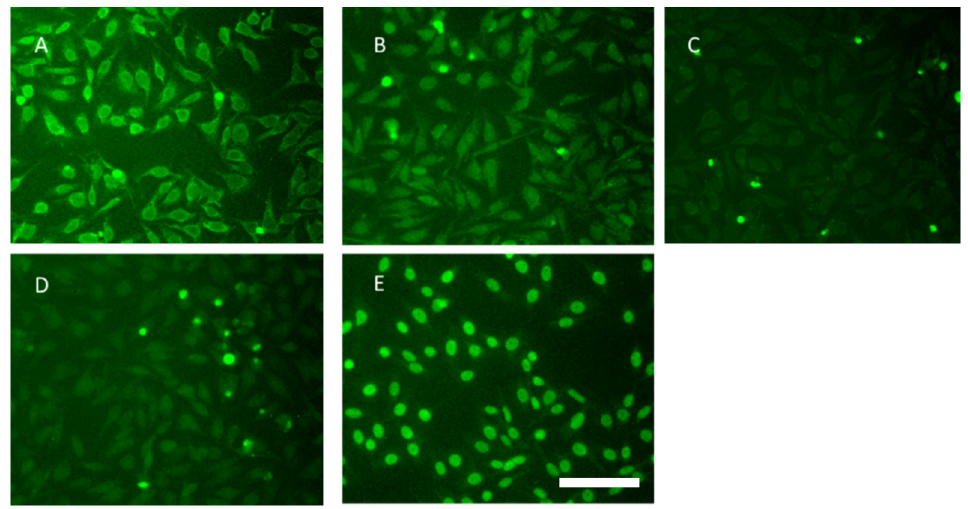
Figure 2. Fluorescence images of ANA tests. ( A ). Model group; ( B ). CTR-nanoflower-treated group; ( C ). IRS-661-nanoflower-treated group; ( D ). IRS-869-nanoflower-treated group; ( E ). IRS-954-nanoflower-treated group. Scale bar: 50 µ m.